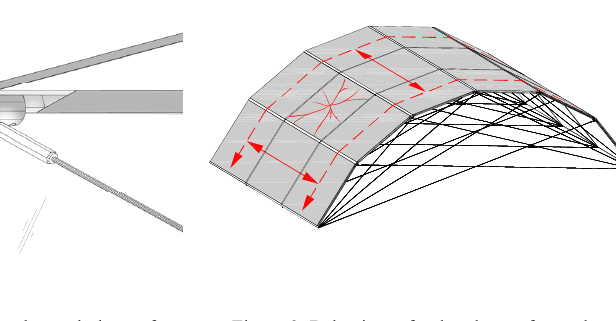
Figure 8: Detail view from underneath the roof. Figure 9: Behaviour after breakage of one glass